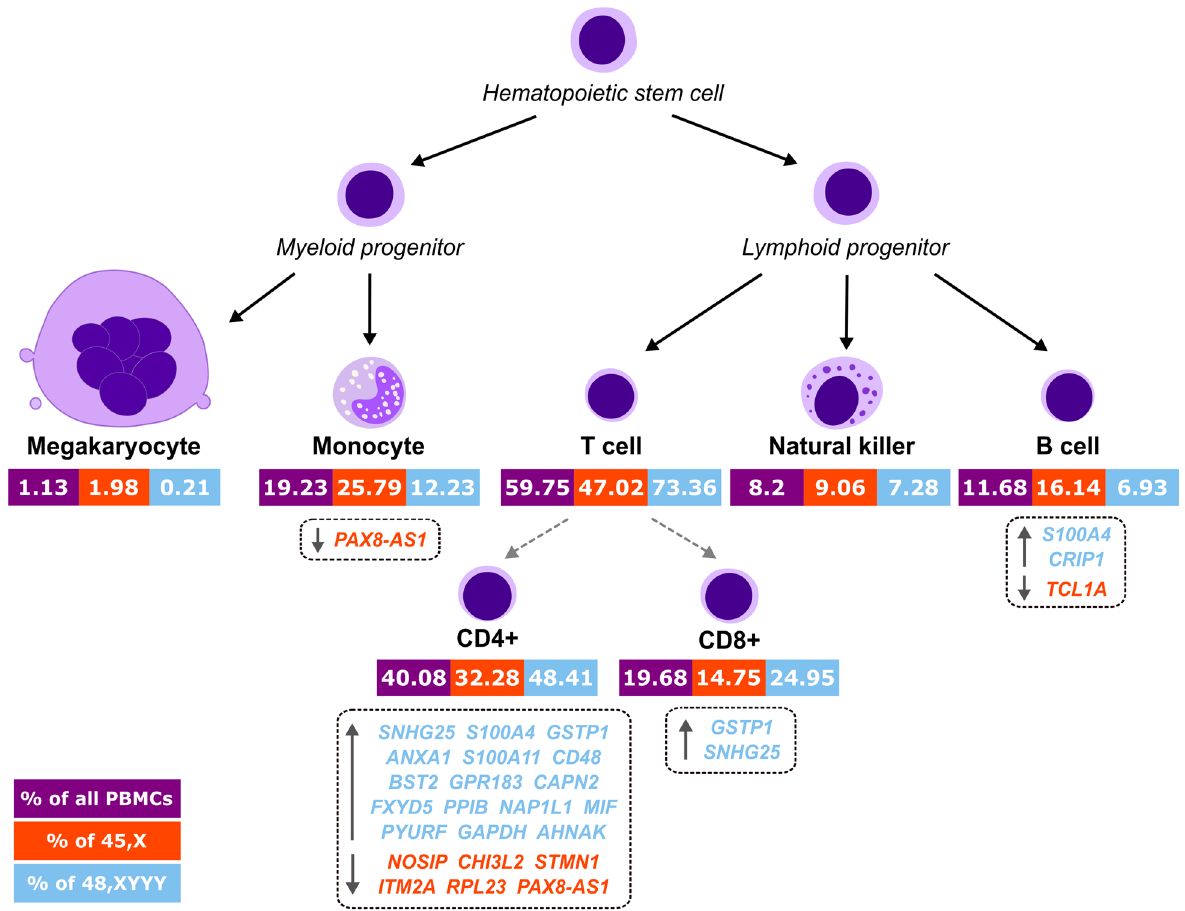
Figure 3. Hematopoiesis scheme with the mosaic 45, X and 48, XYYY cell population fractions and the list of differentially expressed genes. Summarized statistics of the mosaic 45, X and 48, XYYY cell populations are overlaid on the hematopoiesis scheme. Only the main identified cell types are shown. Values shown in the purple, red, and blue boxes correspond to the total number or fractions (%) of single cells among all studied cells, 45, X cells only or 48, XYYY cells only, respectively. Solid black arrows follow the main developmental directions of blood cells. Dashed grey arrows correspond to main paths of lymphopoiesis of different T lymphocytes. List of genes is shown as dashed boxes with up and down arrows presenting the direction of gene